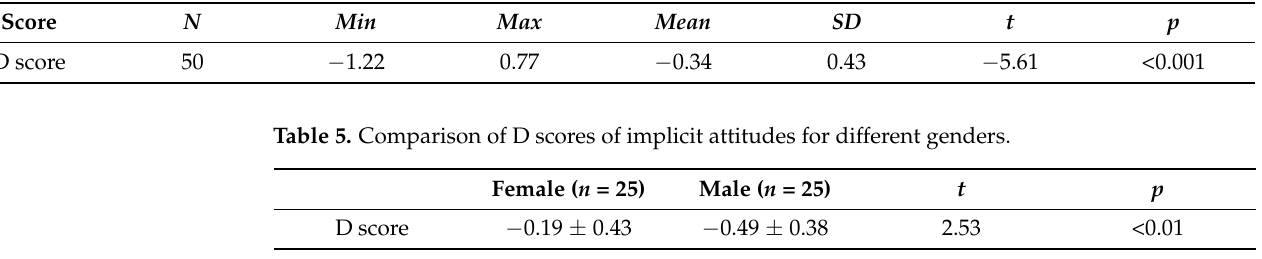
Table 4. D score of implicit attitudes.